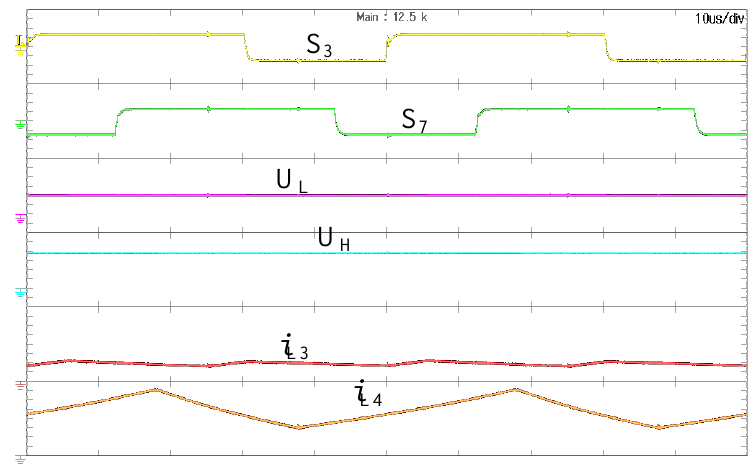
Figure 12. Switch Q7 short circuit experiment.